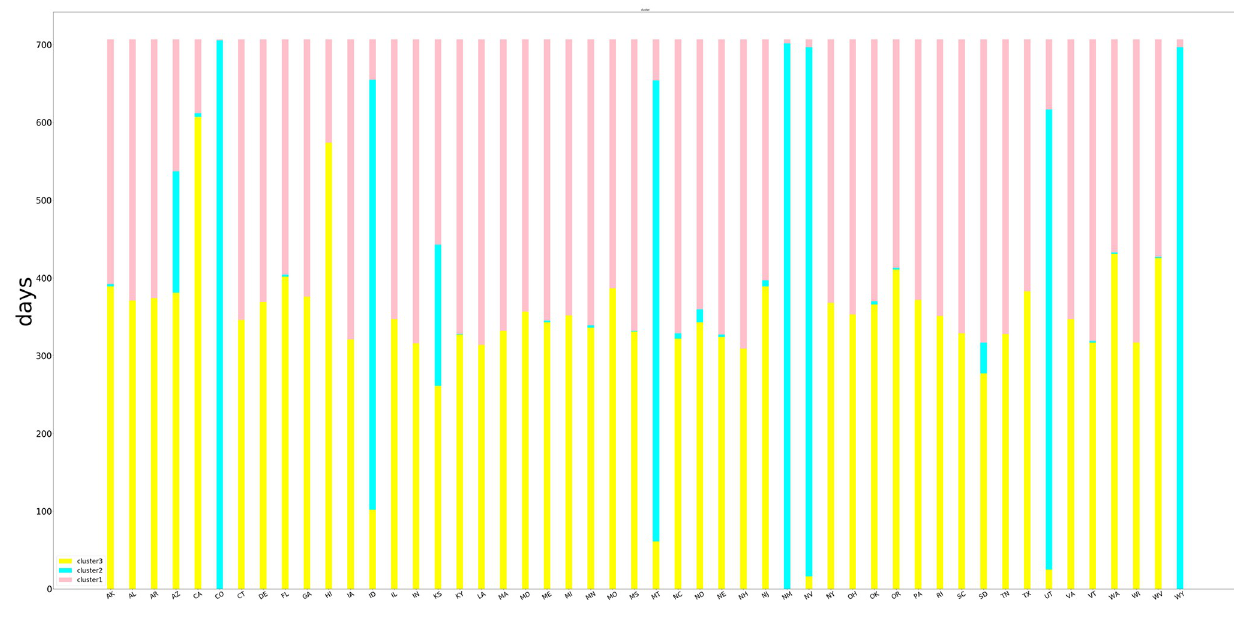
Fig 2. The frequency distribution cluster